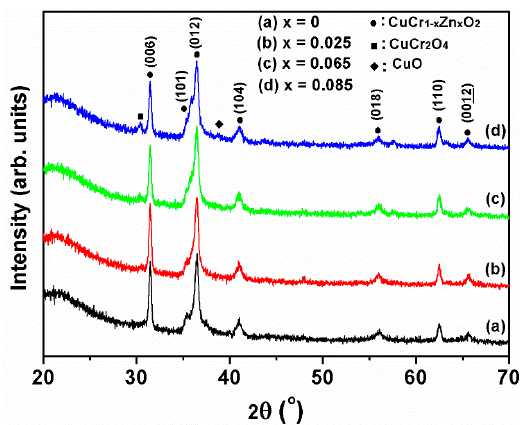
ff raction patterns of the undoped and Zn-doped CuCrO Figure 1. X-ray diffraction patterns of the undoped and Zn-doped CuCrO 2 thin films. Figure 1. X-ray di